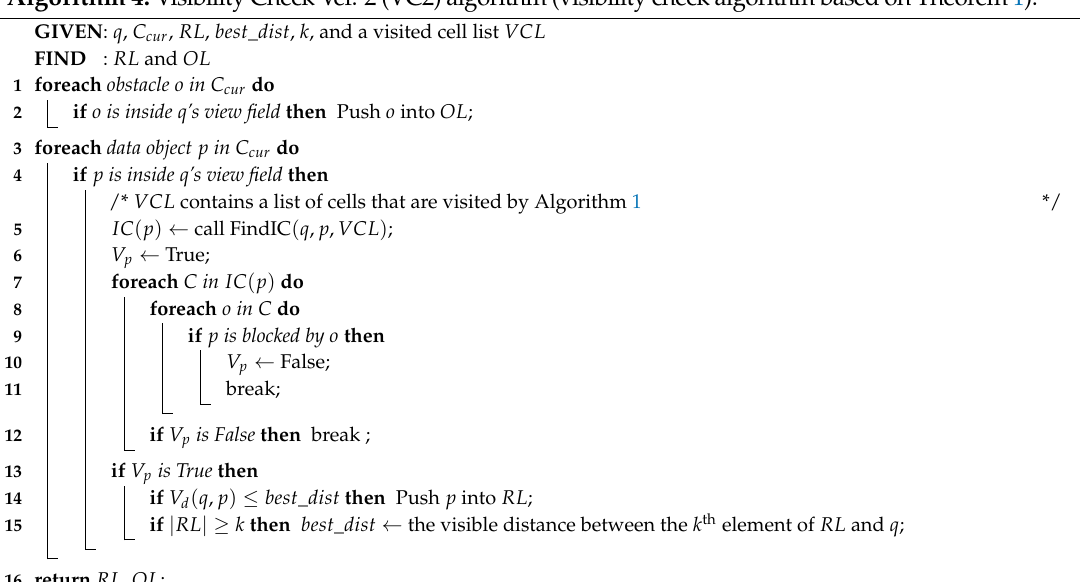
Algorithm 4. Visibility Check Ver. 2 (VC2) algorithm (visibility check algorithm based on Theorem 1).